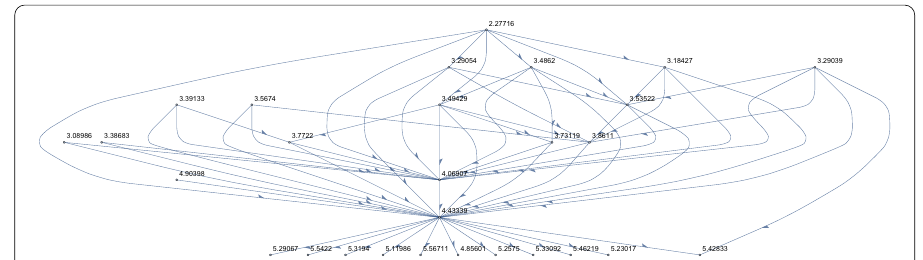
Fig. 4 Neighbourhood Graph Partial Neighbourhood Graph of Narrator 25628 organised by generalised Trophic